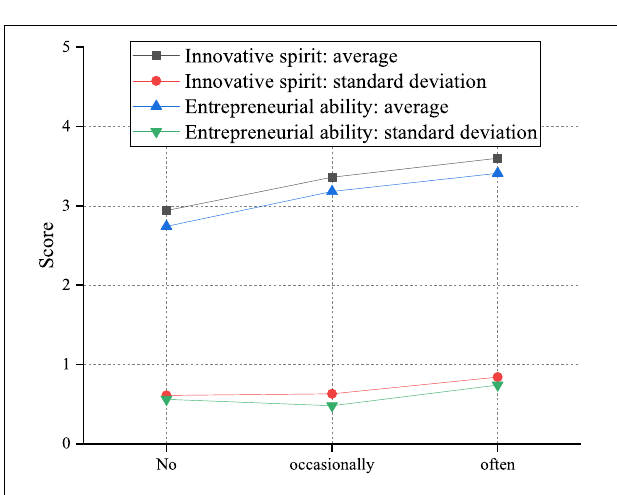
FIGURE 13 | Influence of college students’ participation in practical activities on innovation and entrepreneurship